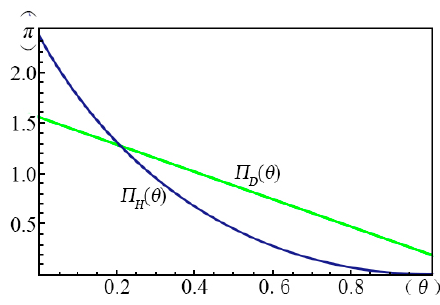
Figure 10. Comparison of the profits of the margin strategy and the intertemporal strategy as a function of (cid:2016) (intercepted from Figure 9).